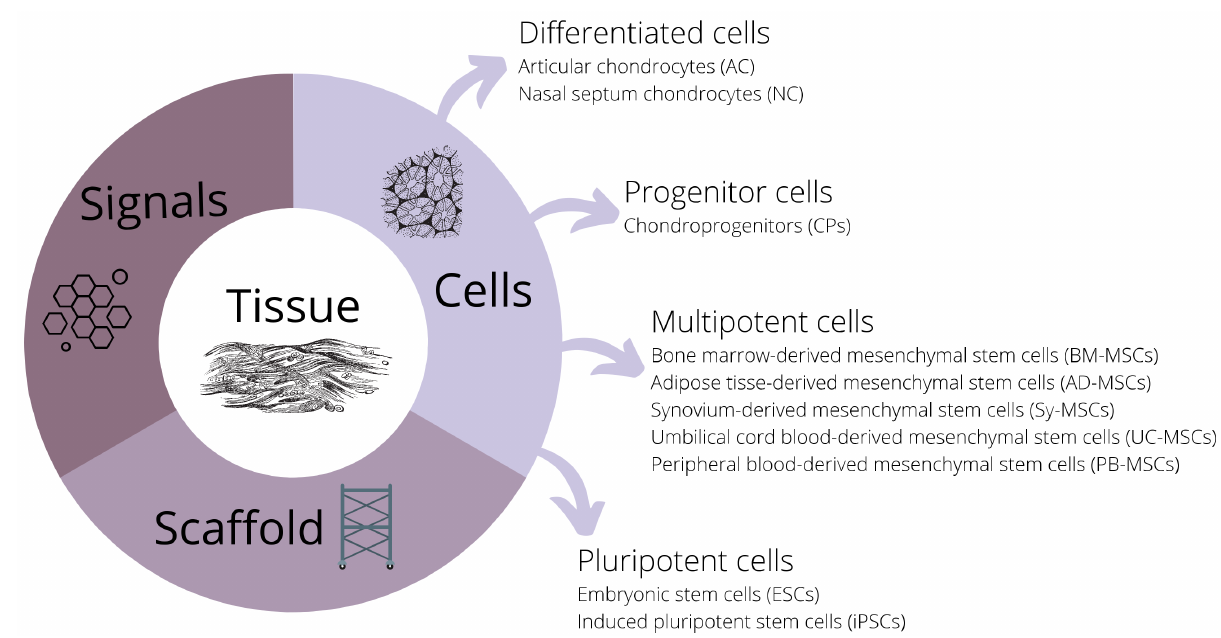
Figure 1. Three essential components of new strategies for cartilage treatment: cells, signals, and scaffolds.